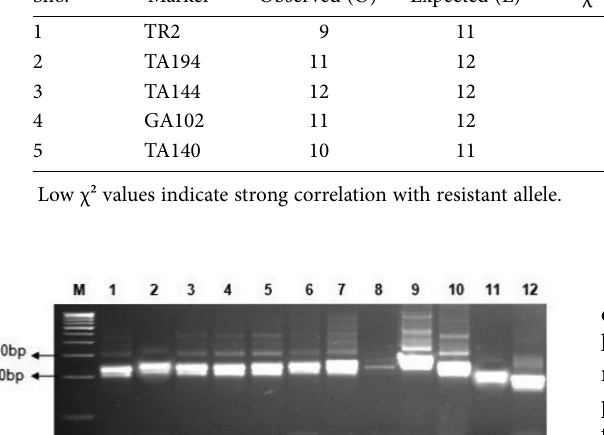
Table 4 Chi-square (χ 2 ) test results of wild chickpeas screened using Bulked BSA for Botrytis grey mould screening. Sno.